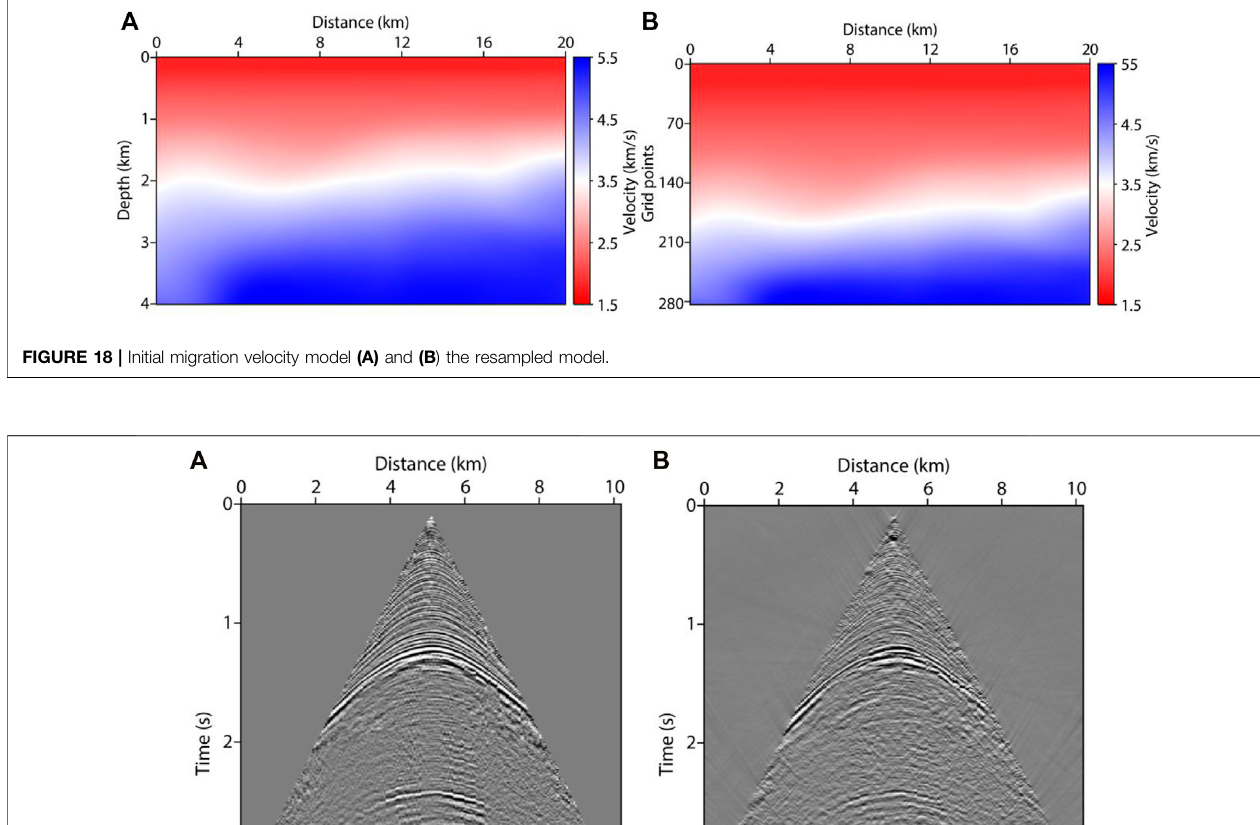
Frontiers in Earth Science |